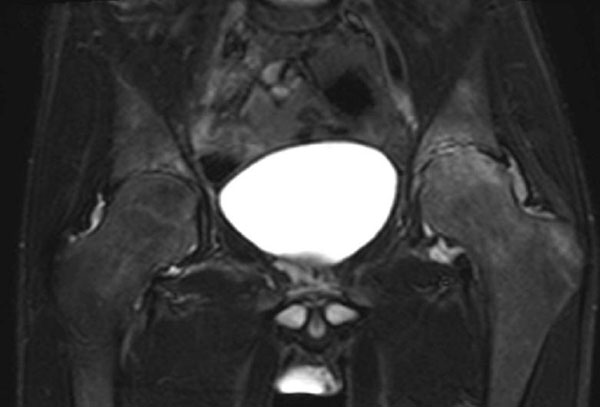
MRI (STIR) of pelvis